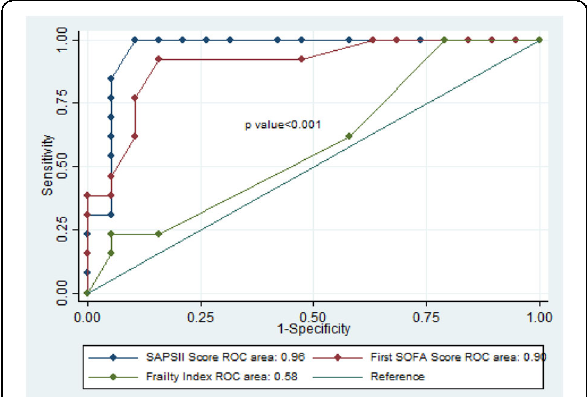
Fig. 3 (abstract 001117). ROC curve of SAPSII, first SOFA and Frailty